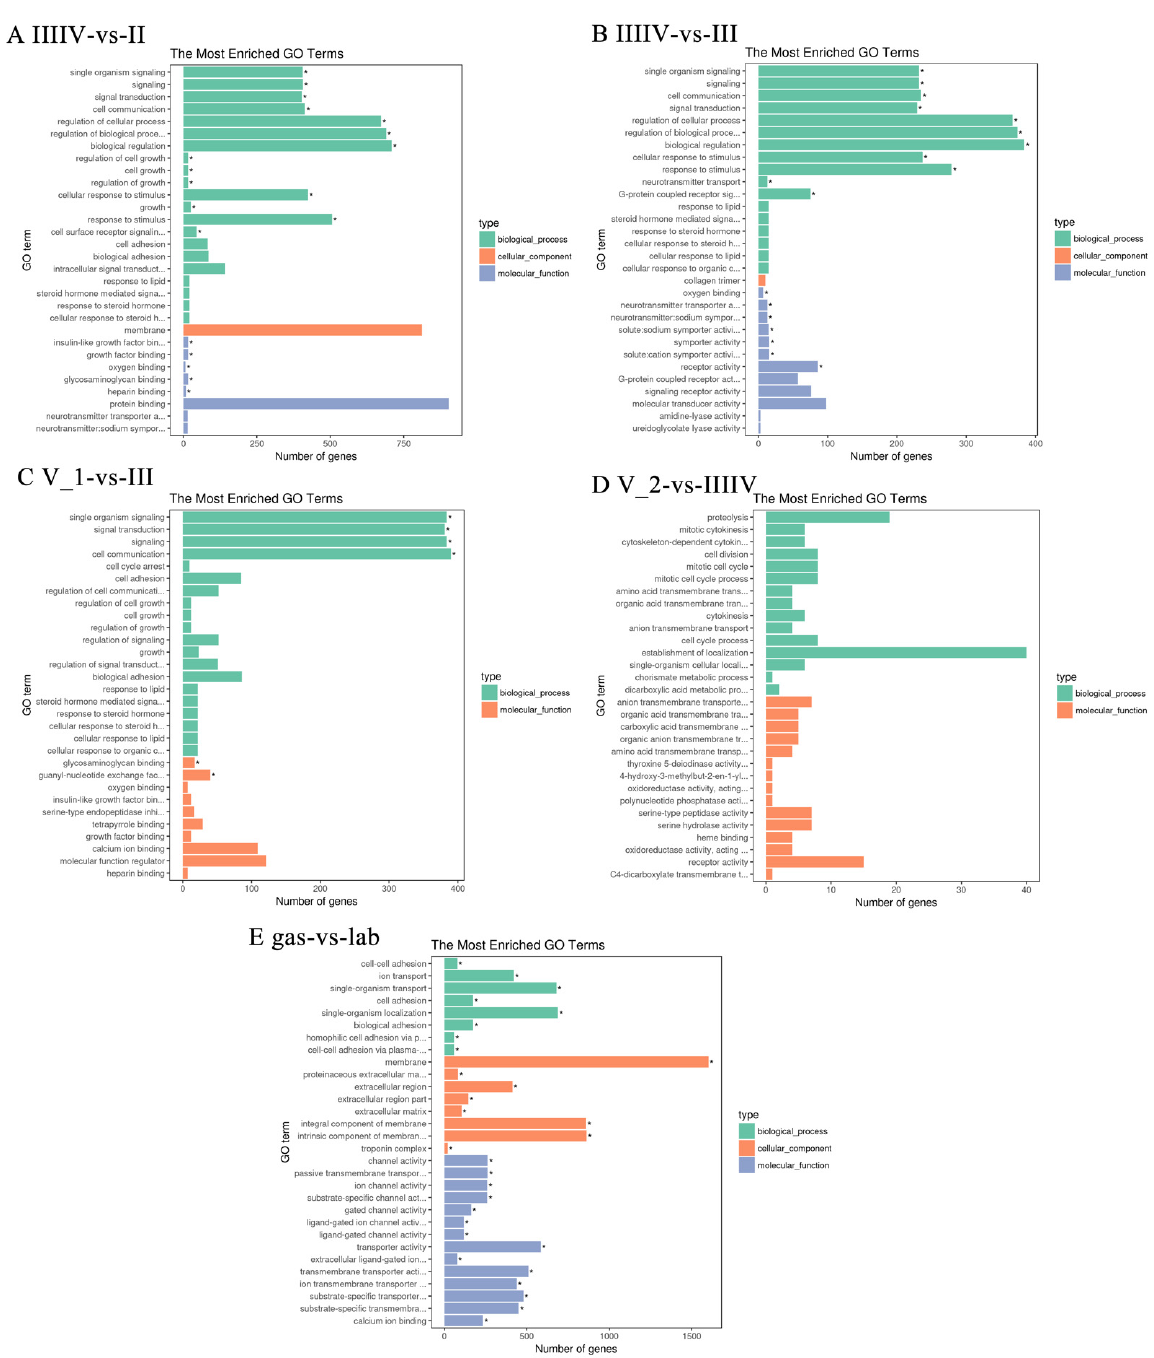
Figure 5. Gene ontology (GO) analysis of the DEG(s) with a two-fold difference. ( A ) IIIIV vs II, ( B ) each term. The y-axis shows the specific terms. The asterisk represents the corrected p value < 0.05 for each GO